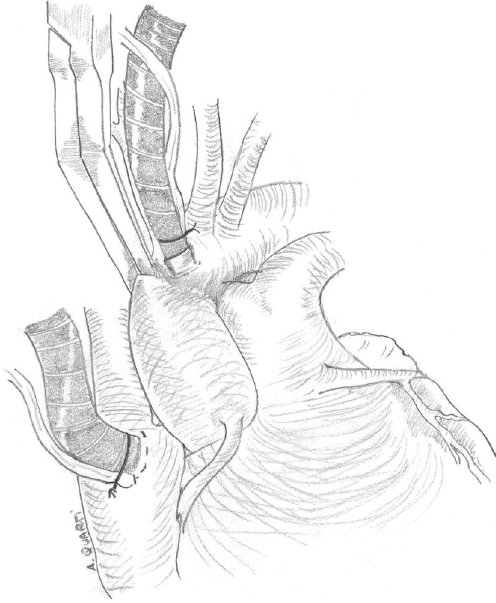
Figure 1: Coronary anatomy.